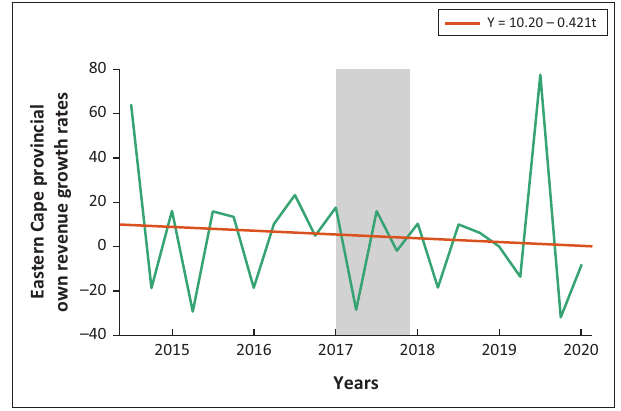
FIG URE 1: Eastern Cape Province’s own revenue generation (2014Q2 to